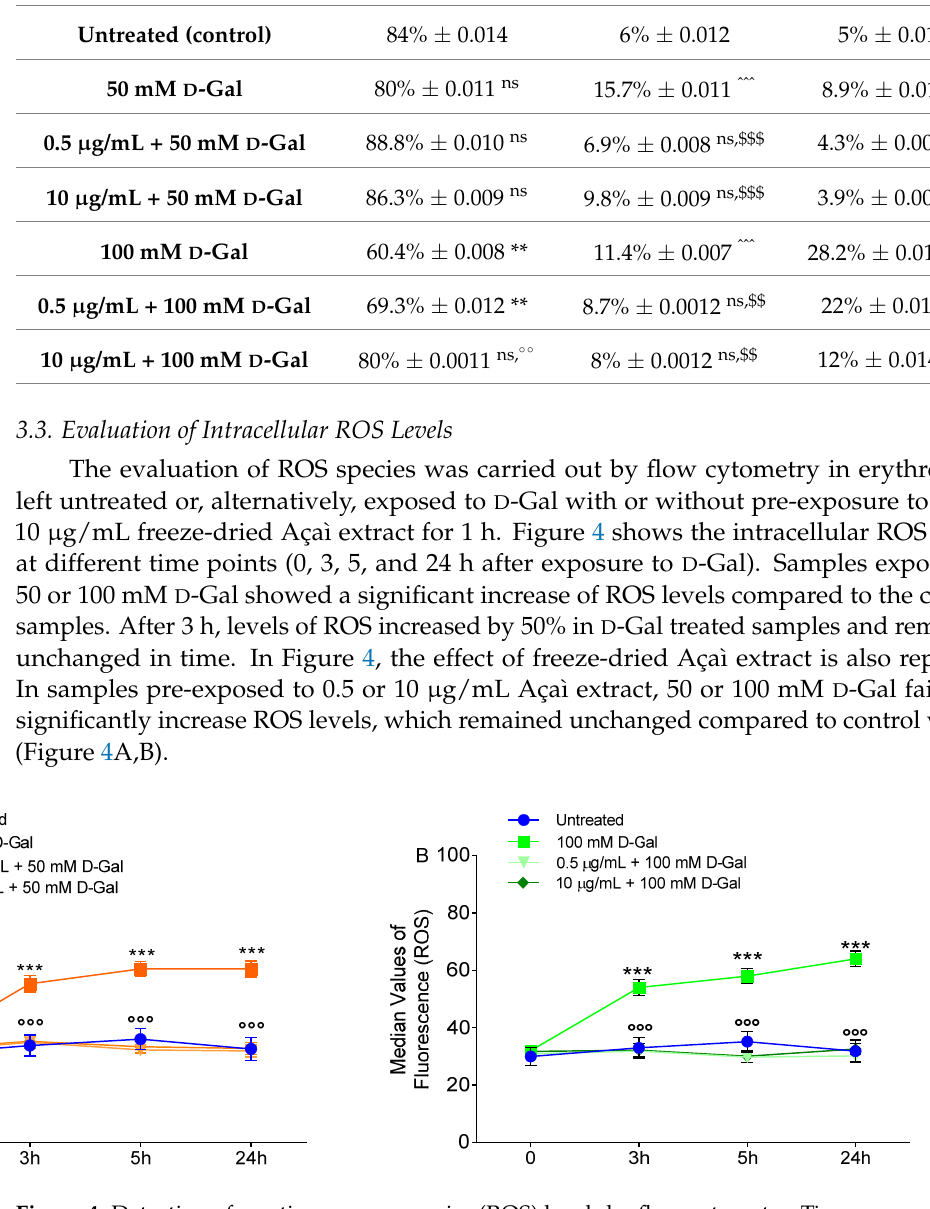
Figure 4. Detection of reactive oxygen species (ROS) levels by flow cytometry. Time course of ROS production in erythrocytes left untreated (control) or treated for 24 h with 50 ( A ) or 100 mM ( B ) D -Gal, with or without pre-exposure to 0.5 or 10 µg/mL freeze-dried Açaì extract for 1 h. ns, not statistically significant versus control; ***, p < 0.001 versus control; °°° , p < 0.001 versus D -Gal, one-way ANOVA followed by Bonferroni’s post hoc test ( n = 8).